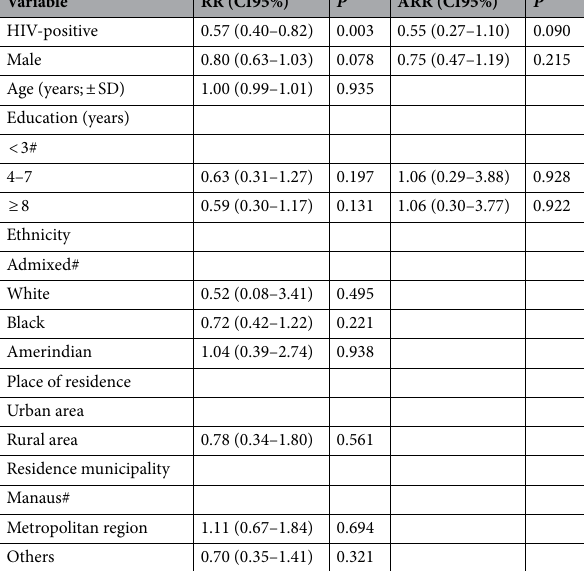
Table 3. Impact of HIV-status and other variables on P. vivax recurrences in the state of Amazonas, Brazil, 2012–2020. # Reference